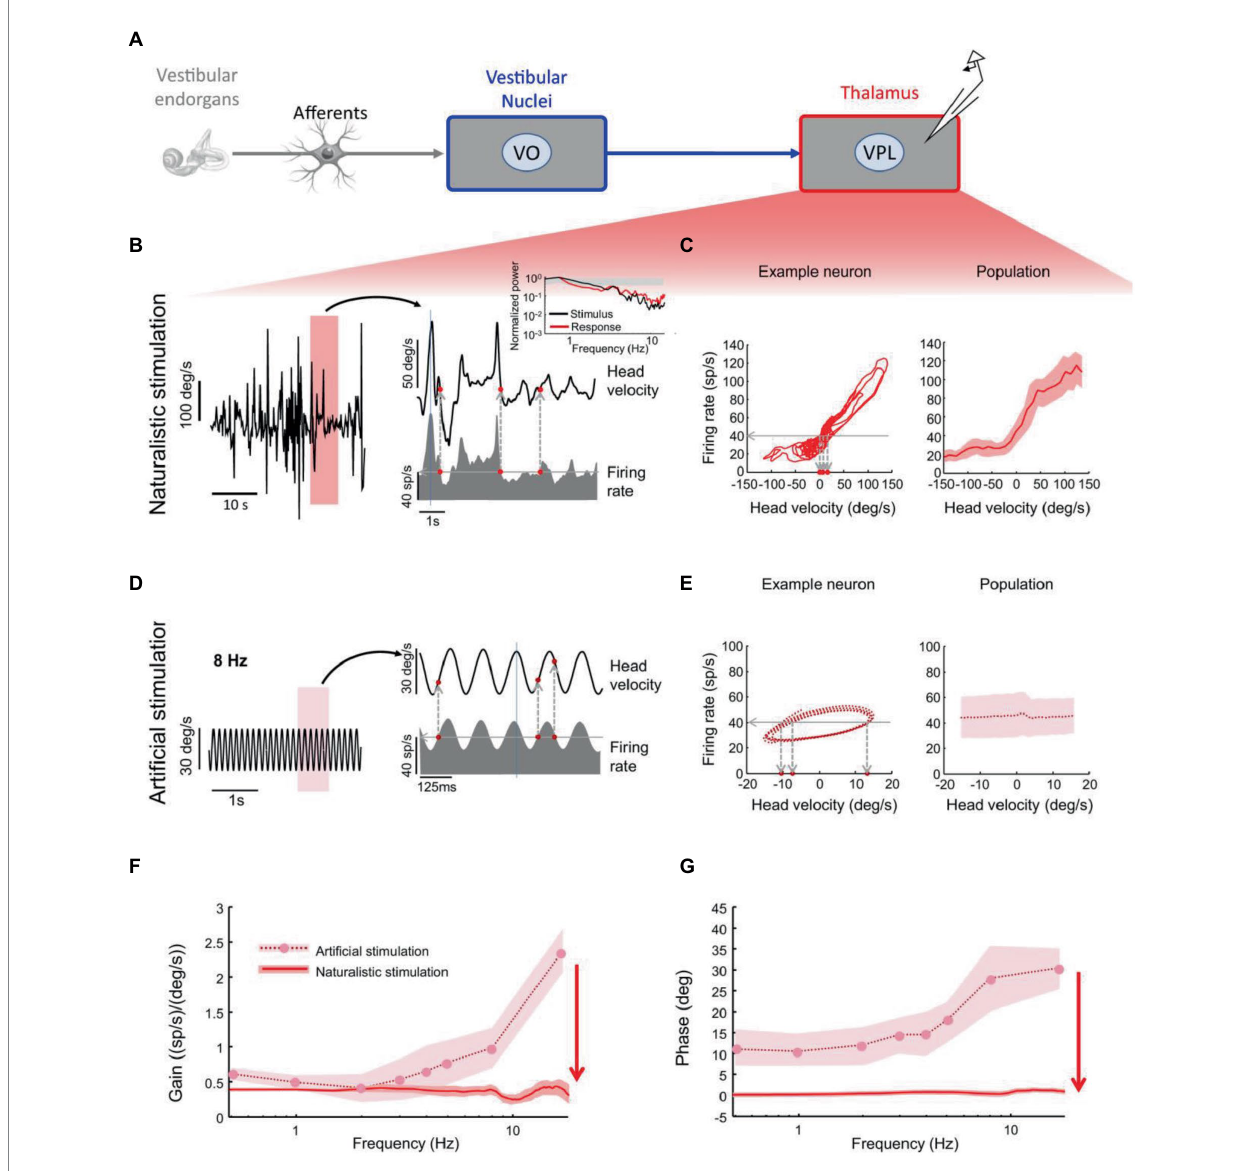
FIGURE 4 Vestibular thalamocortical neurons show reliable responses to naturalistic self-motion but not to artificial self-motion stimuli. (A) Schematic of peripheral and central vestibular pathways. Recordings are from the ventral posterior lateral (VPL) thalamus. (B) Left: Time series of a naturalistic self- motion stimulus. Right: Segment of this stimulus corresponding to the rectangle (top) and the firing rate response (bottom) of a VPL neuron. Inset: Stimulus (black) and spike train (red) power spectra from this neuron. Gray band: 95% confidence interval from a Poisson process whose power spectrum is independent of frequency. (C) Left: Firing rate versus head velocity for the neuron in panel (B) . Right: Population-averaged ( N = 28) firing rate as a function of head velocity. (D) Left: Artificial sinusoidal (8 Hz) self-motion stimulus. Right: Segment this stimulus corresponding to the rectangle (top) and the firing rate response (bottom) from a VPL neuron. (E) Left: Firing rate versus head velocity for the neuron in panel (D) . The same firing rate (horizontal dashed line) can be elicited by multiple values of the head velocity (vertical dashed lines), which leads to ambiguity. Right: Population- averaged ( N = 28) firing rate as a function of head velocity. (F) Population-averaged neural gain as a function of frequency for artificial (dashed) and naturalistic (solid) self-motion. (G) Population-averaged phase as a function of frequency for artificial (dashed) and naturalistic (solid) self-motion. Reproduced with permission from Carriot et al.